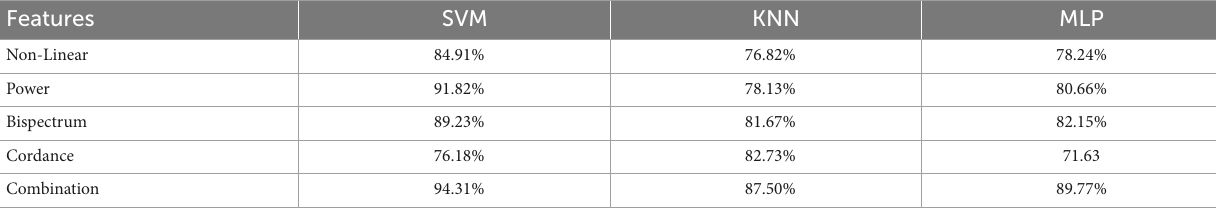
TABLE 6 Accuracy of SVM, KNN, and MLP classifiers with the selected features (individually and in combination) for classifying NR and R.